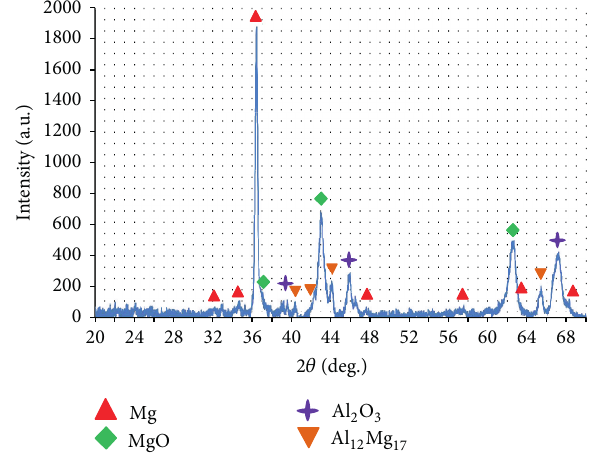
Figure 5: XRD of the product of the reaction between pure Mg and Al 2 O 3